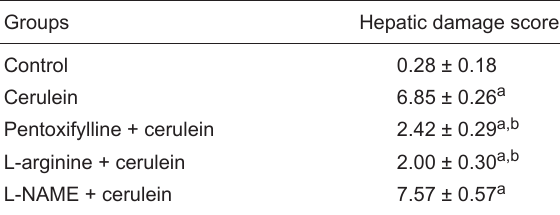
Table 1. Hepatic damage scores (hepatocyte necrosis, intracel- lular vacuolization, vascular congestion, hemorrhage, sinusoidal dilatation, and inflammatory infiltration with a maximum score of 18) for the groups studied. Groups